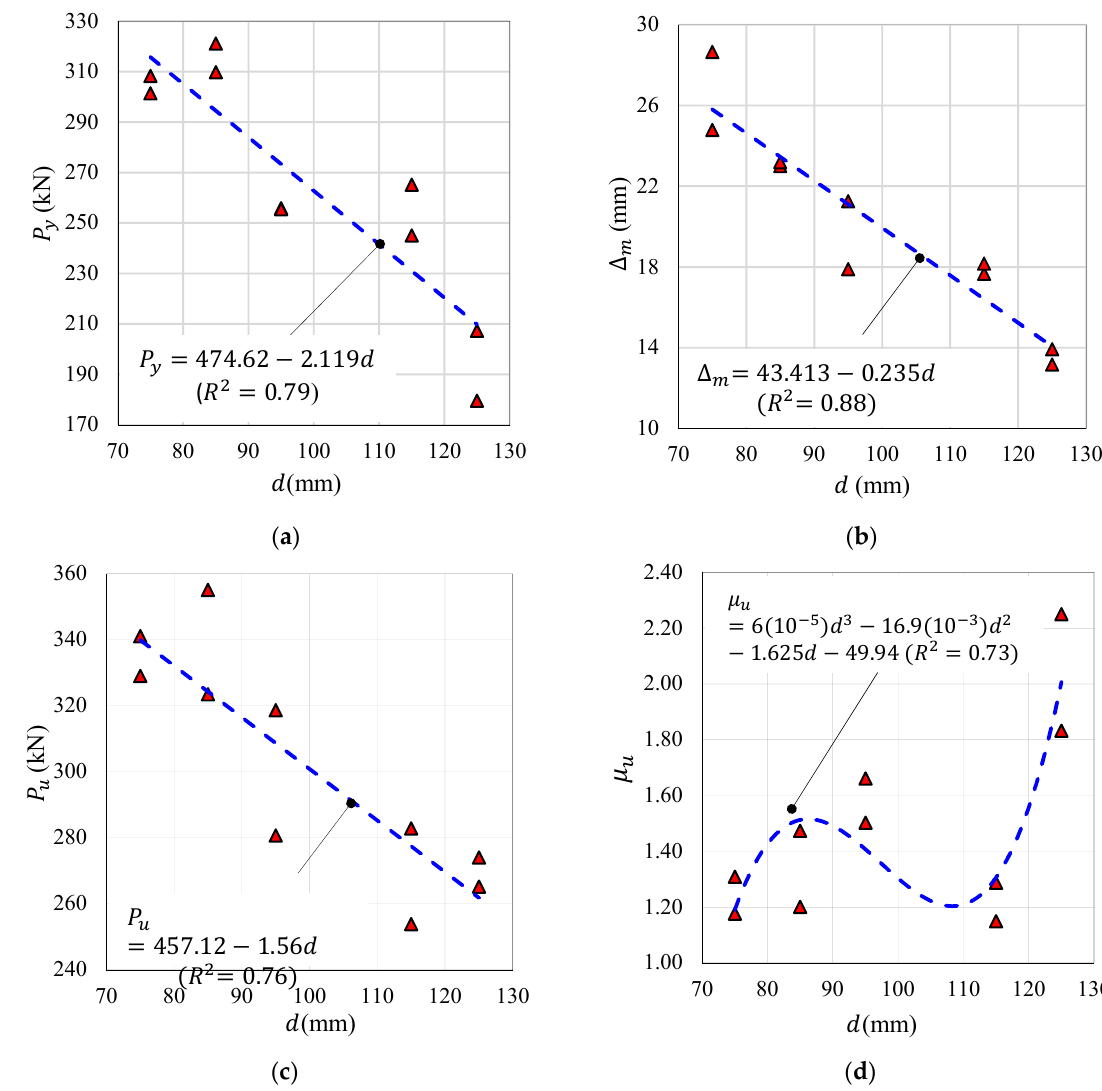
Figure 10. Observed correlations: ( a ) P y − d , ( b ) ∆ m − d , ( c ) P u − d , and ( d ) µ u − d